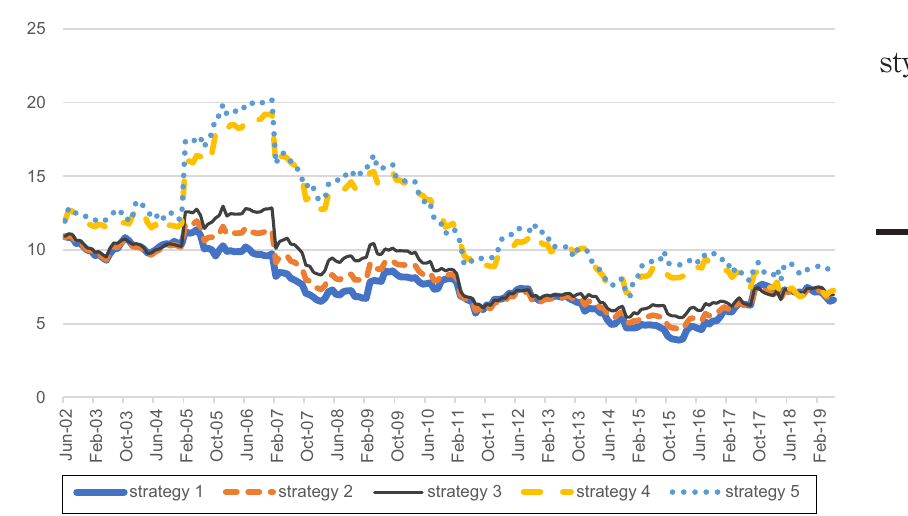
Figure 3. Time-series of tracking errors estimated from style timing strategy: